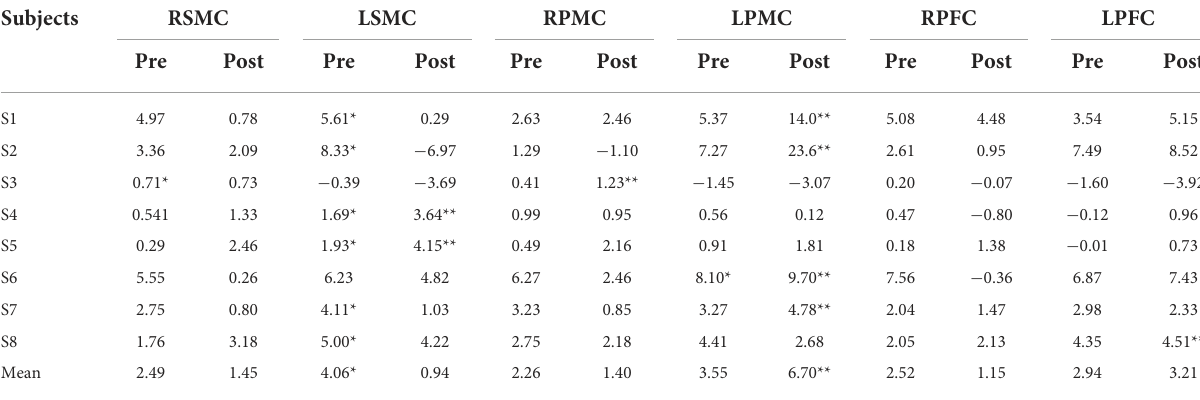
TABLE 2 Mean beta value (mol)of 6 ROIs pre and post intervention of all the